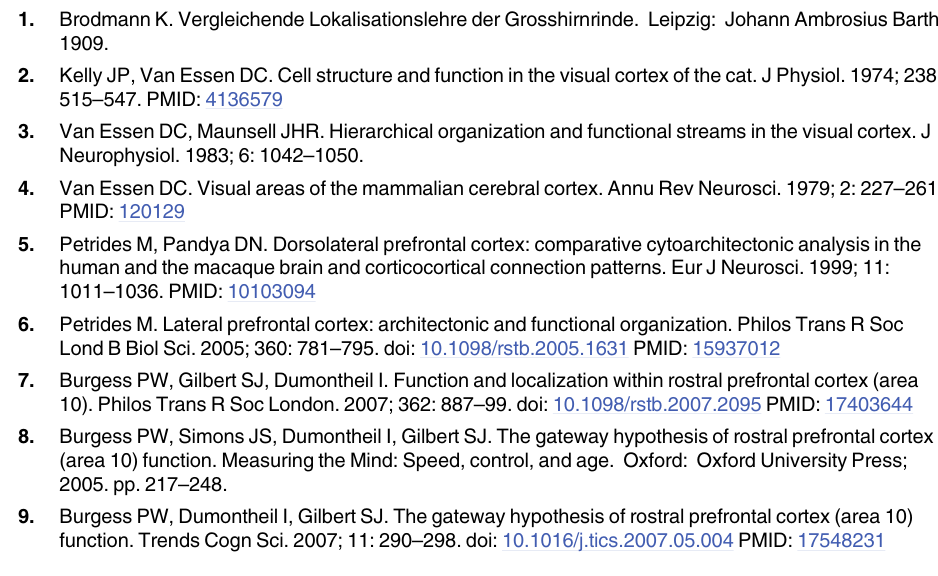
S1 Table. Peaks from clusters showing significant functional co-activation with seeds in the left frontal pole. Coordinates of cluster peaks are in MNI space. When clusters covered multi- ple regions, local maxima are reported. Brodmann areas were obtained via the Talairach dae- mon. BA: Brodmann Area, vox: number of voxels in cluster. (XLSX) S2 Table. Peaks from clusters showing significant functional co-activation with seeds in the right frontal pole. Coordinates of cluster peaks are in MNI space. When clusters covered mul- tiple regions, local maxima are reported. Brodmann areas were obtained via the Talairach dae- mon. BA: Brodmann Area, vox: number of voxels in cluster.